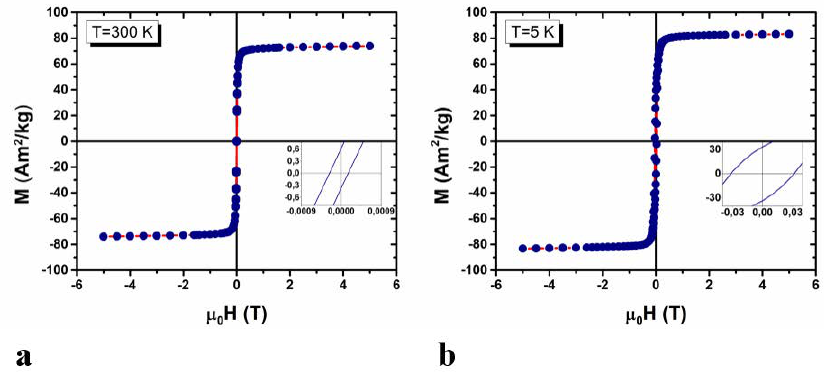
Figure 2. ( a ) Hysteresis loop measured at 300 K and ( b ) 5 K, in the field range ± 5 Tesla. In the insets, we report the low field